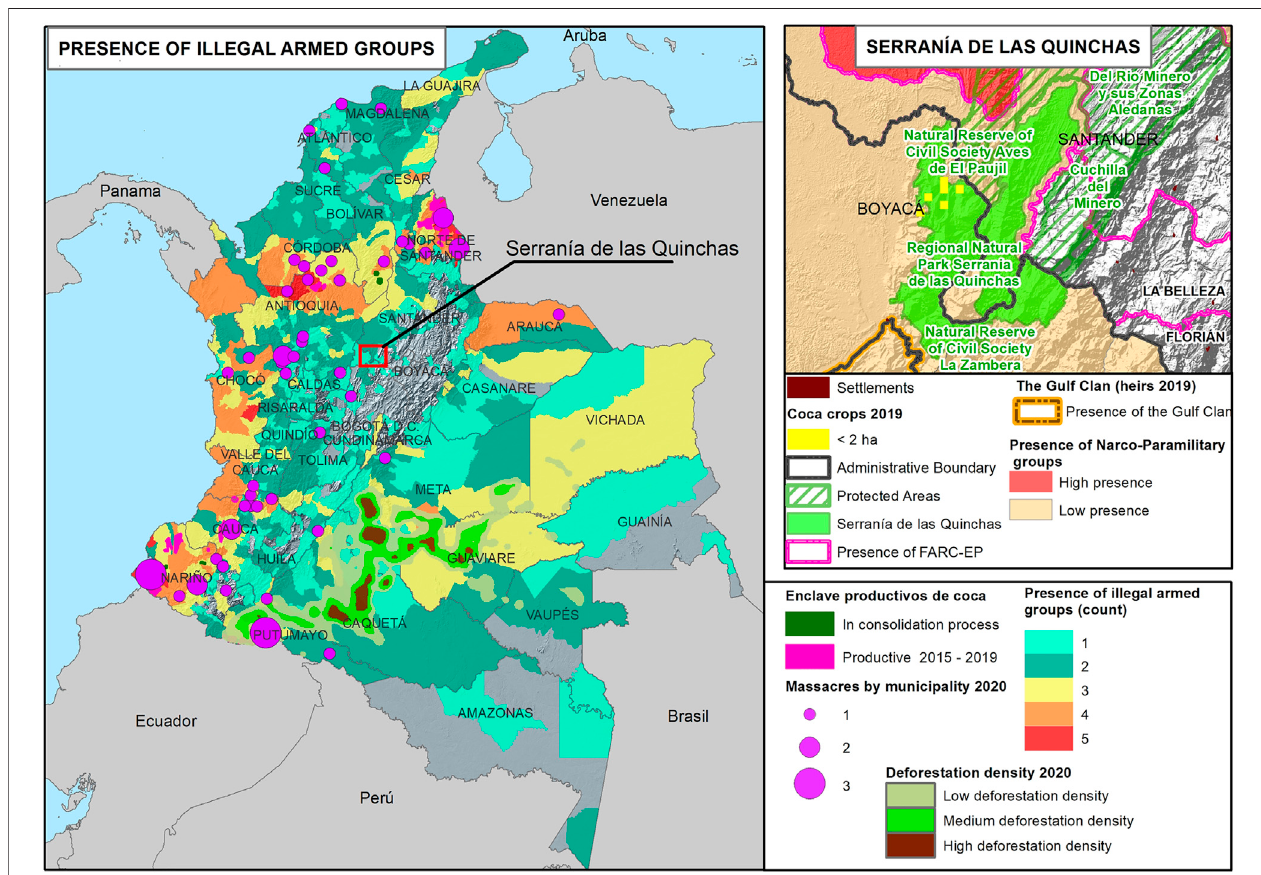
FIGURE 1 | Map of location of the Serrania de las Quinchas in Colombia in the Andean Mountains. Produced by Alejandra Gomez (2020), commissioned by the authors 5 .